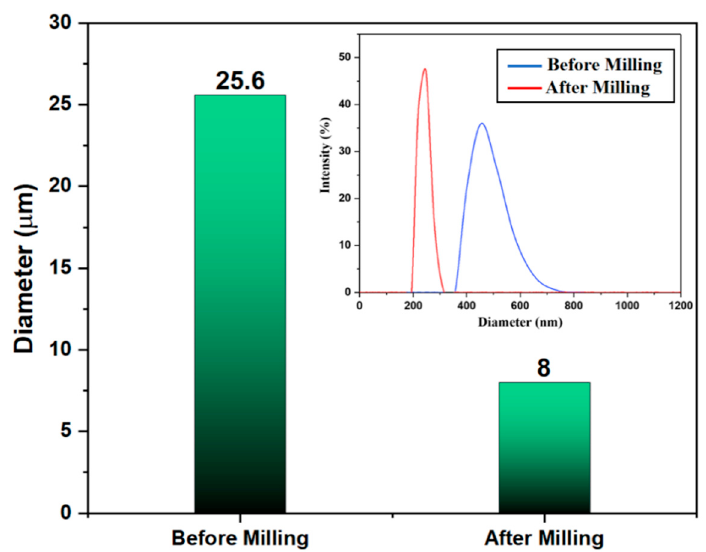
Figure 3 . Particle size measurement . Figure 3. Particle size